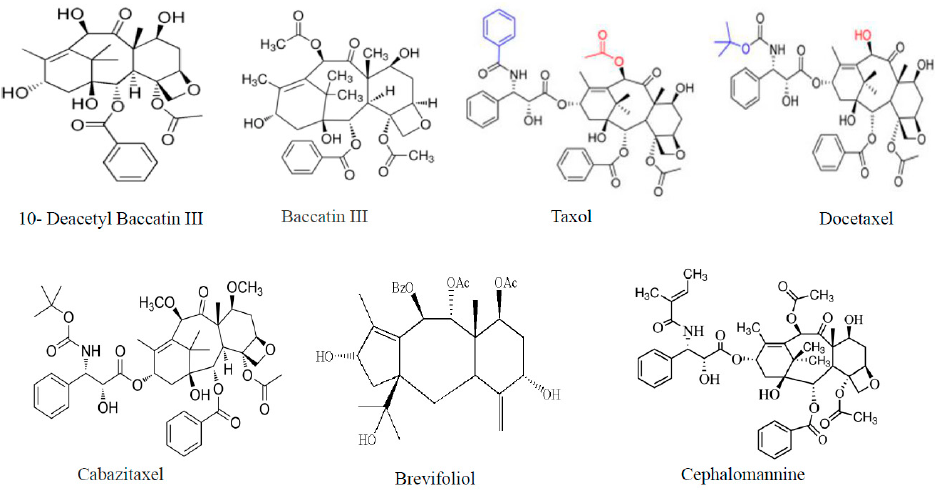
Figure 1. Chemical structure of Taxol and other Taxoid compounds.